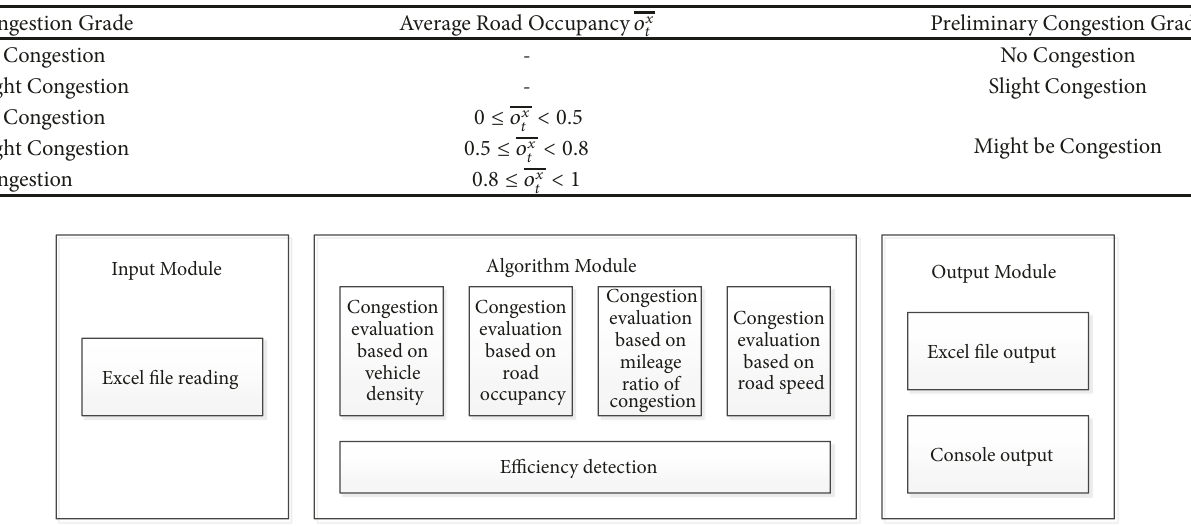
Table 3: Result of congestion grade based on road occupancy.